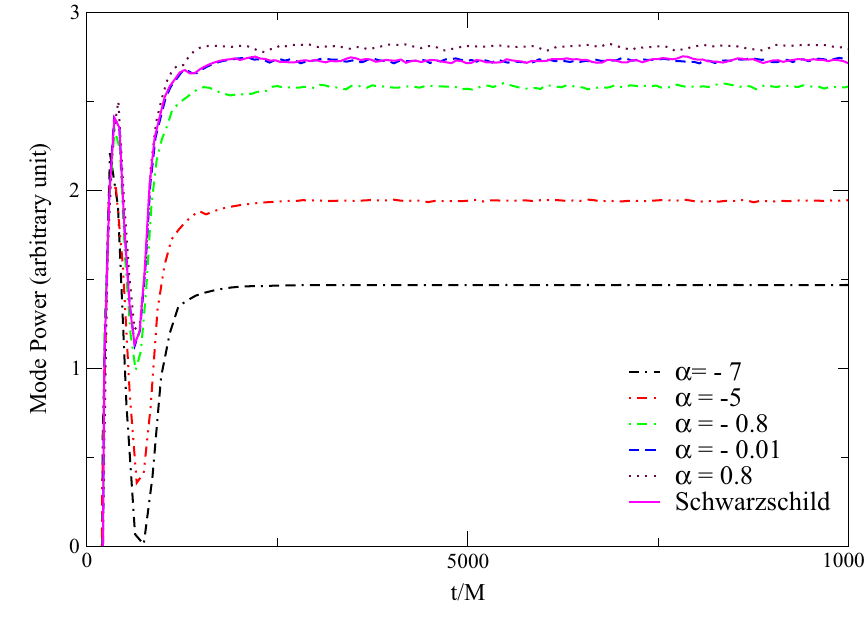
Fig. 7 m = 1 mode growth evolution around the EGB black hole for different values of α and Schwarzschild black hole. The region of interested is zoomed to see the saturation points and oscillations of the mode powers after they reached the steady